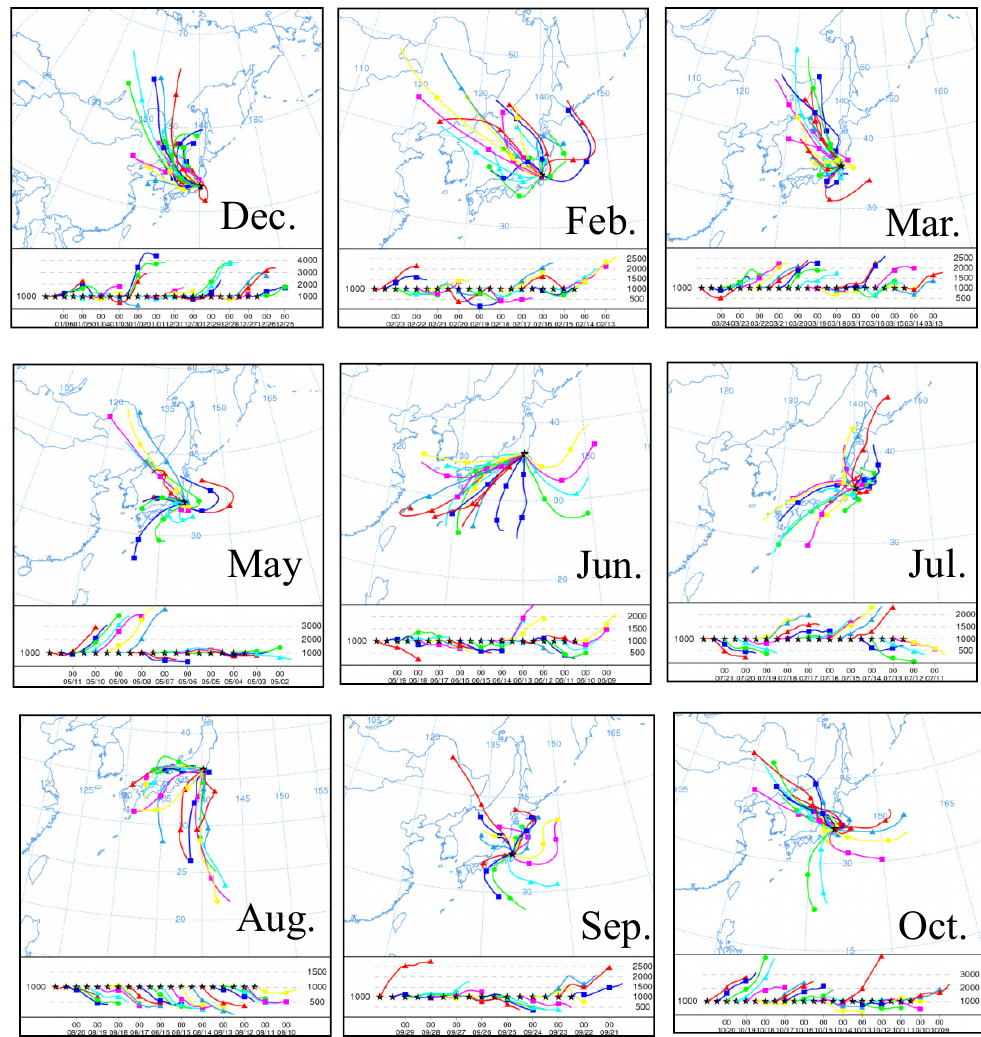
Fig. 1. Backward trajectory analyses at Tsukuba during the sampling for this study.